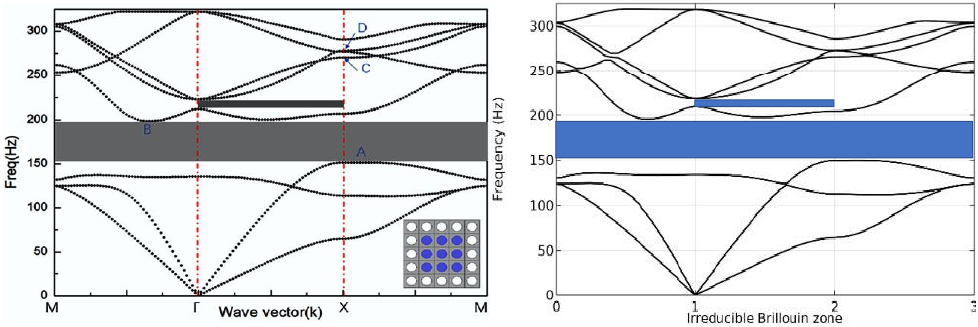
Figure 6. Result from Sun et al.(L) and regenerated result (R).